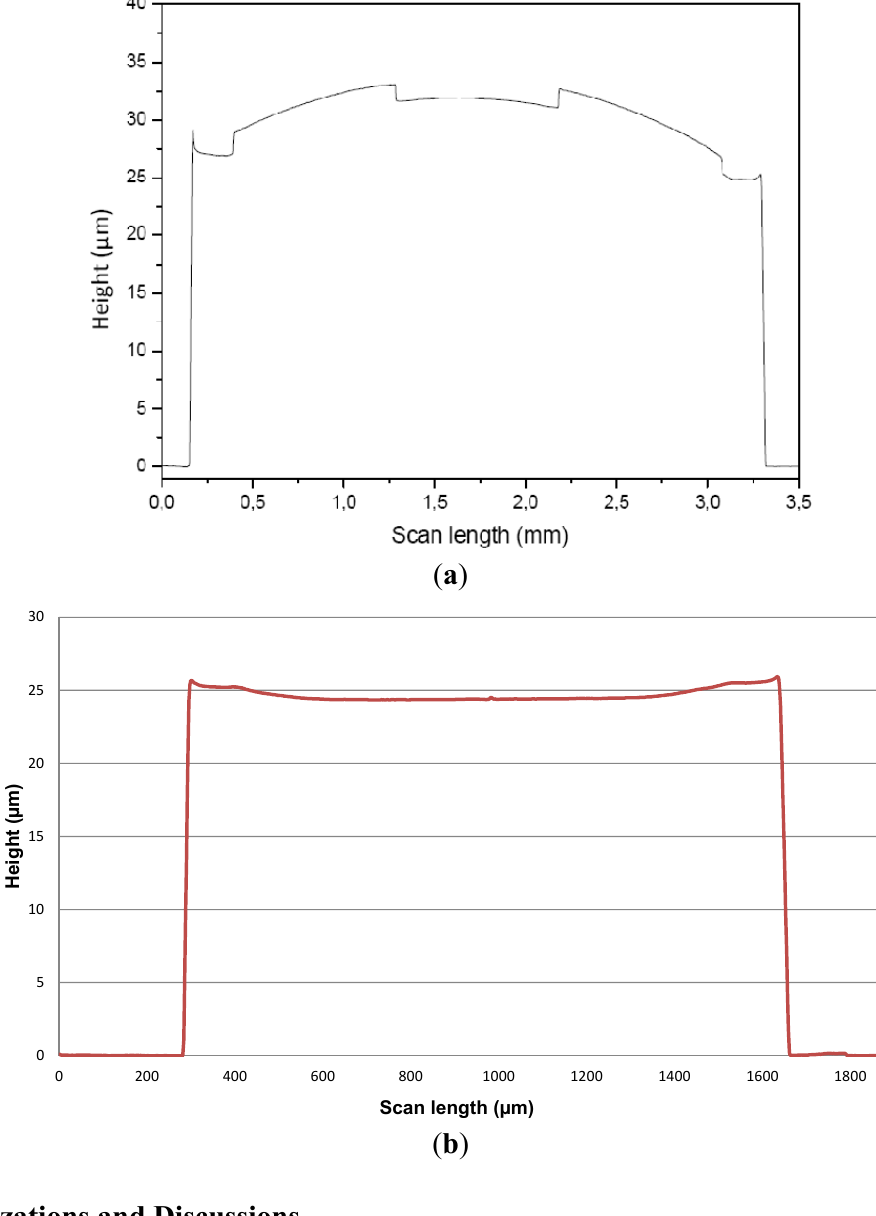
Figure 7. BCB cap profiles with and without upper tuning electrodes. ( a ) Measured BCB cap profile after upper tuning electrodes fabrication. ( b ) Measured BCB cap profile without upper tuning